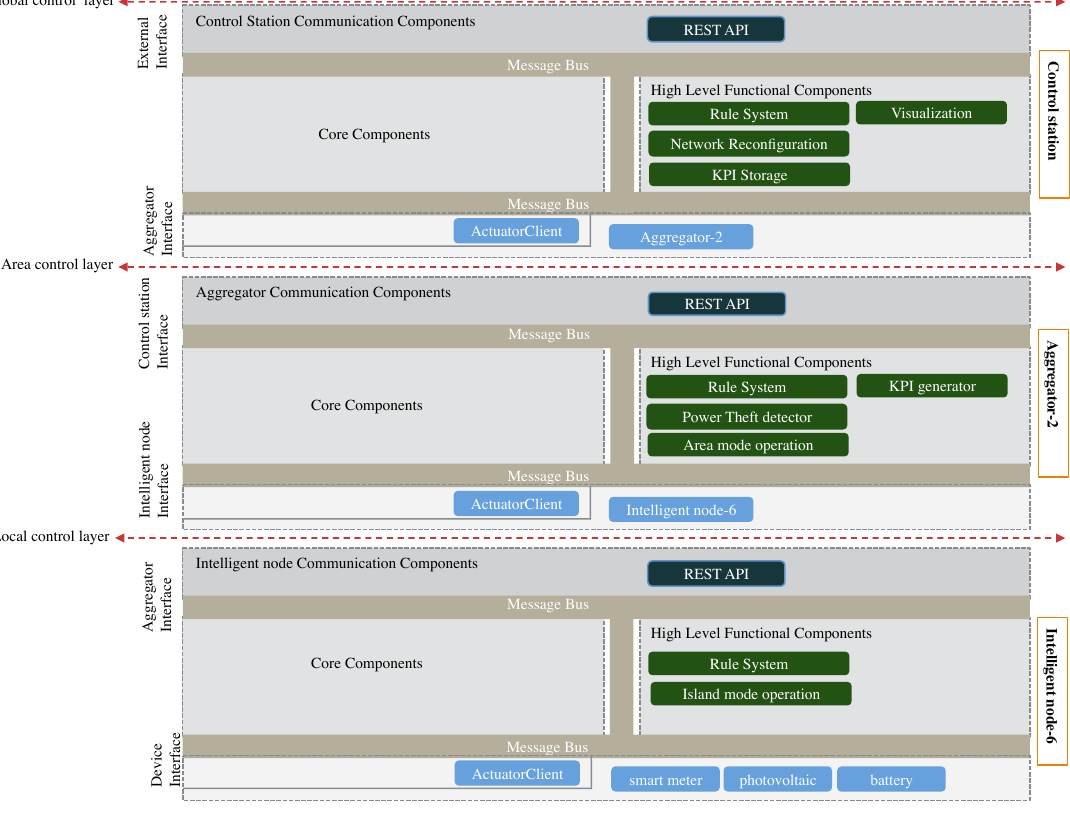
Figure 6. Detailed view of the Microgrid Controller (MC) implementation at each layer of the proposed